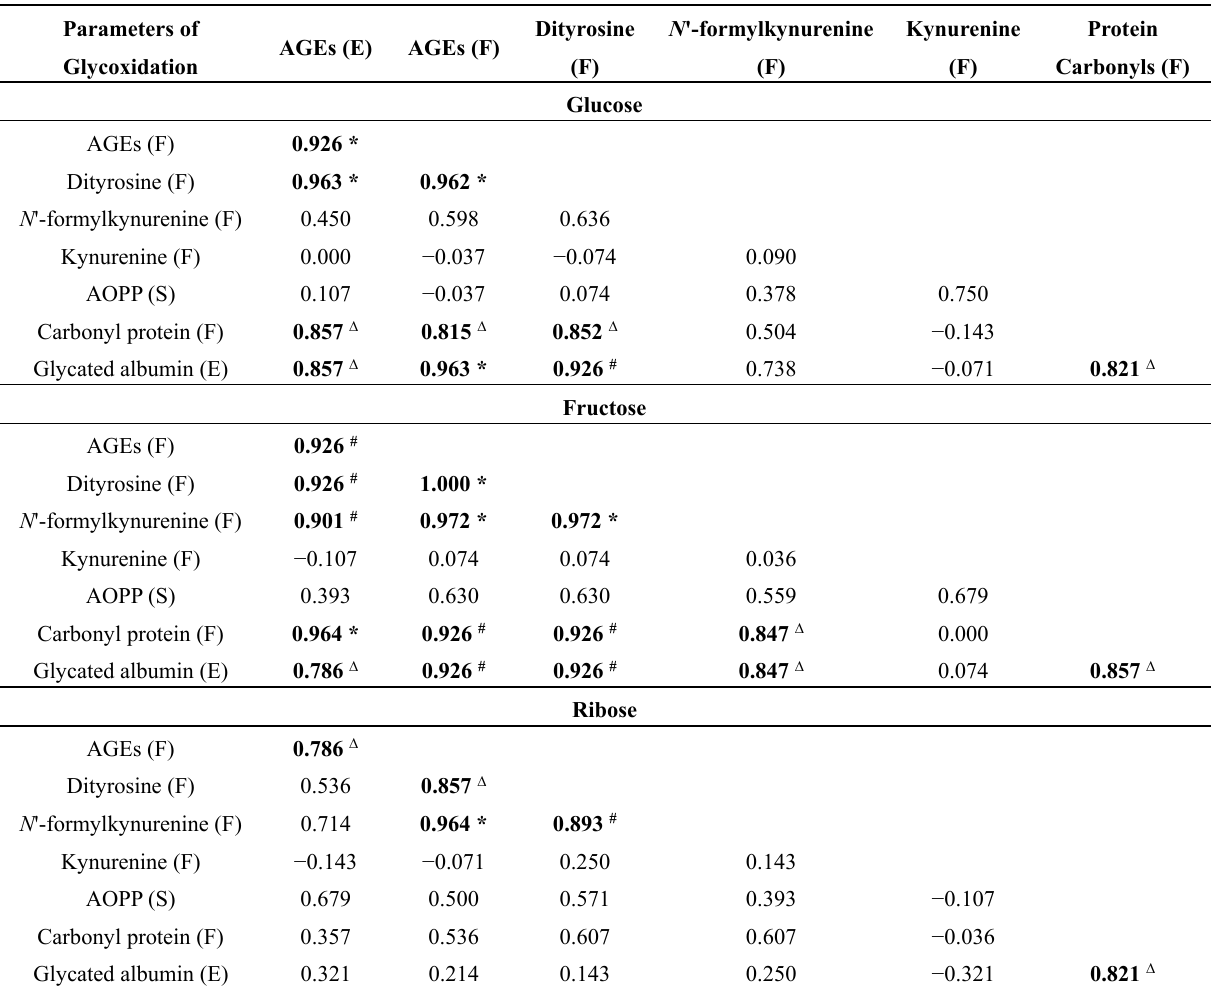
Table 6. Correlation coefficients between various parameters of glycoxidation and protein oxidative damage for BSA subject to glycation with various sugars in the presence of eight polyphenols. E, ELISA; F, fluorometry, S, spectrophotometry; ∆ p < 0.05, # p < 0.01, * p <